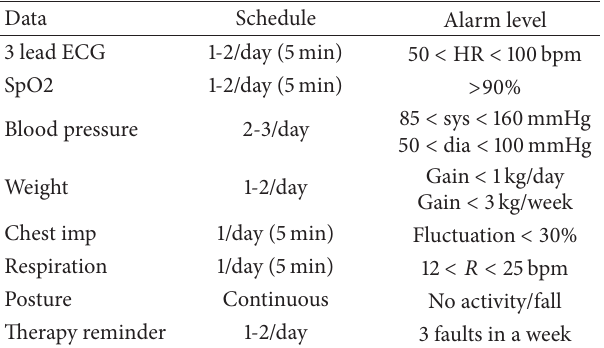
Table 2: The operating